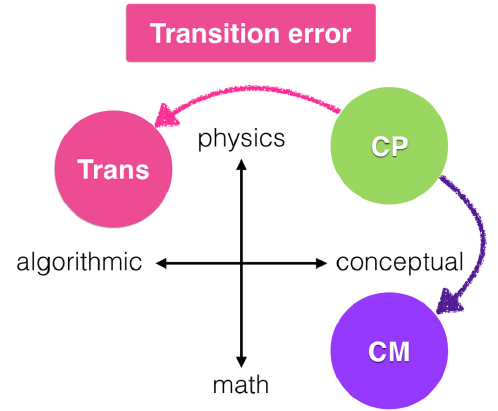
FIG. 2. Transition error: Conceptual physics frame (CP), Conceptual mathematics frame (CM), Transition error